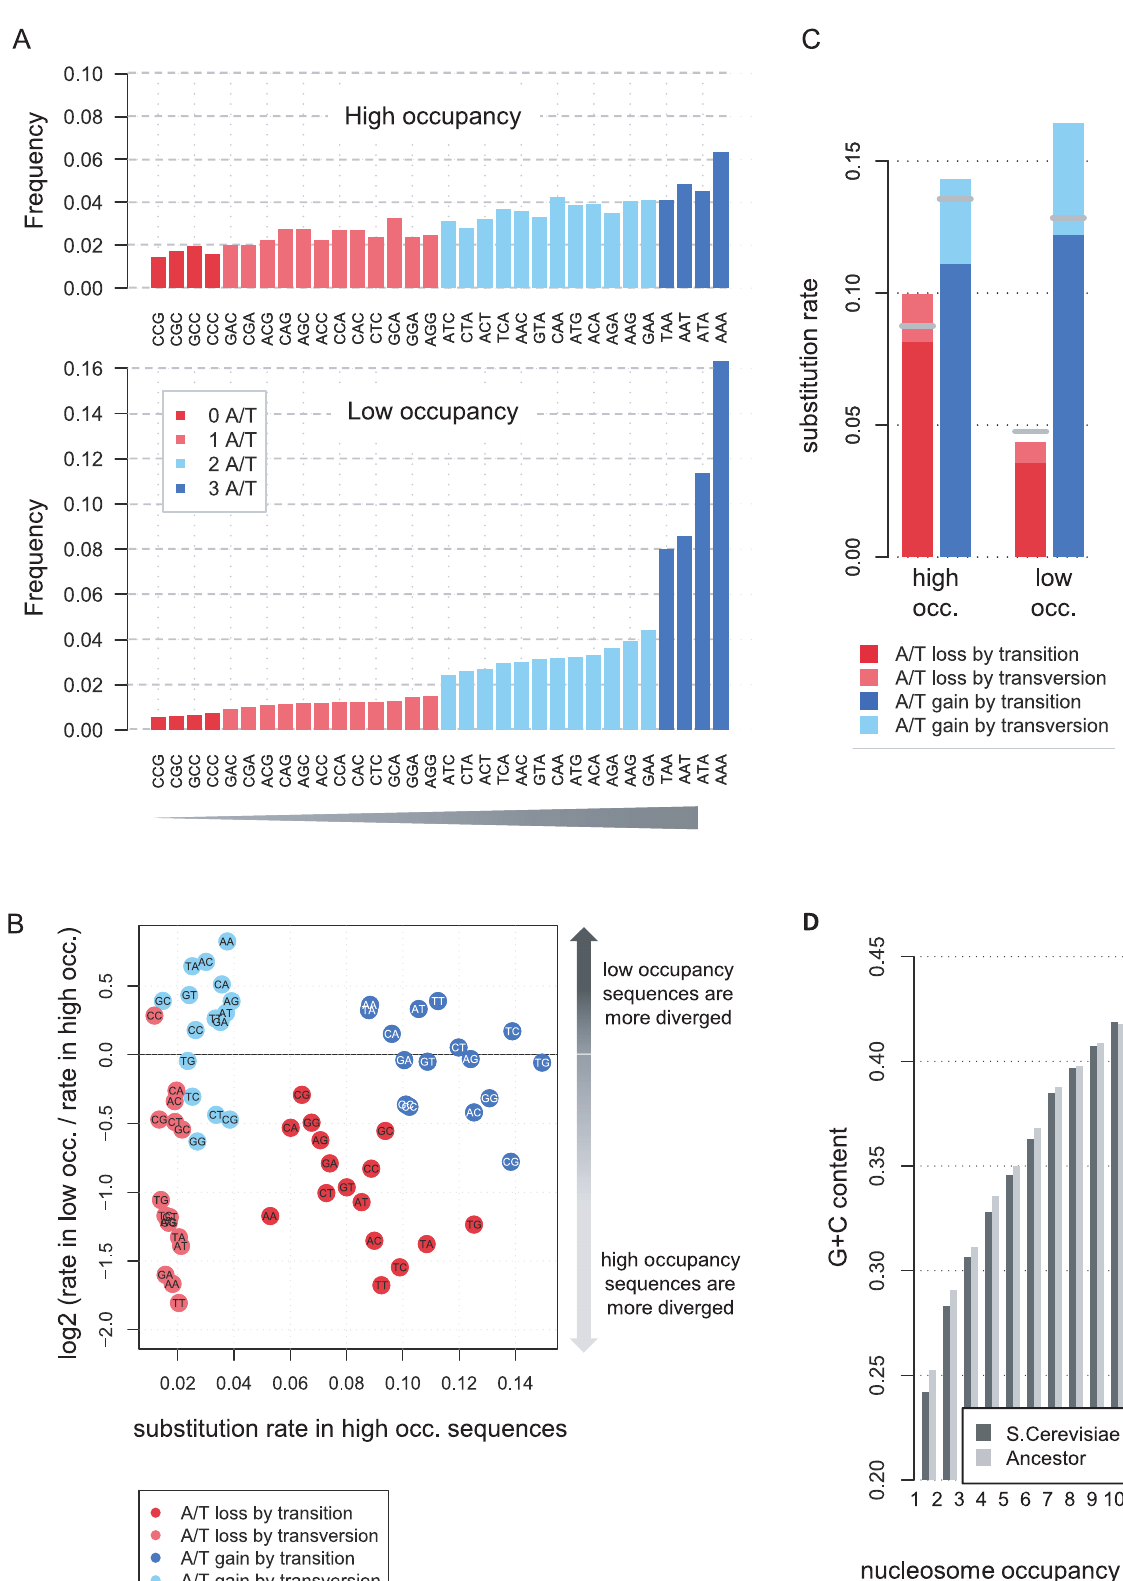
Figure 4. Compensatory evolution at TSS-distal sequences. A ) The TSS-distal trinucleotide spectrum is modified. Shown are trinucleotide frequencies at TSS-distal high and low occupancy sequences. Compared to the distribution at TSS-proximal sequences, the low occupancy sequences contain more A/T trinucleotides and less G/C trinucleotides. B ) TSS-distal low occupancy sequences lose A/T slowly and